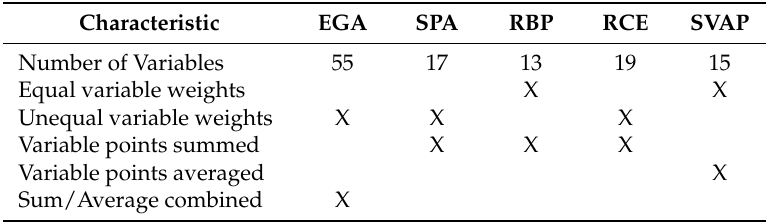
Table 3. Characteristic comparisons of five rapid stream assessment methods.